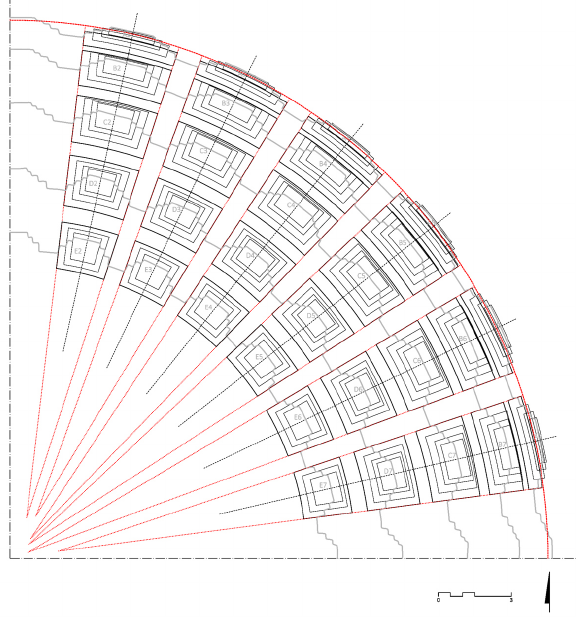
Figure 8. Comparison between the ideal model and the mesh Figure 10. Study of the northeast quadrant of the dome surface extracted from the point cloud. Top with the convergent lines passing through the external vertices of the coffers.